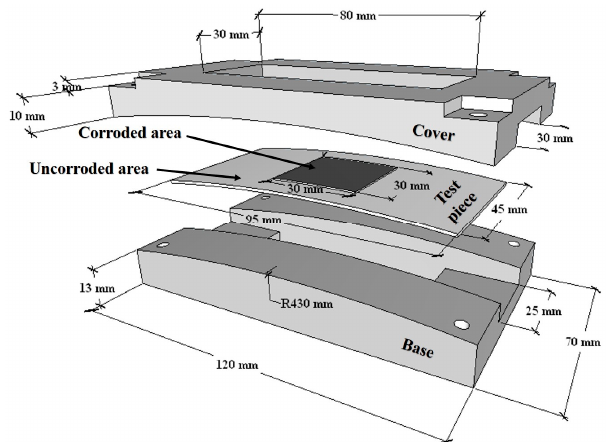
Figure 3. Test piece and apparatus for ACM (atmospheric corrosion monitoring) sensor. The apparatus comprises of a base, test piece, and cover. A corroded area, 30 mm in length and 30 mm in width, was formed at the center of the test piece; the remaining area was uncorroded.